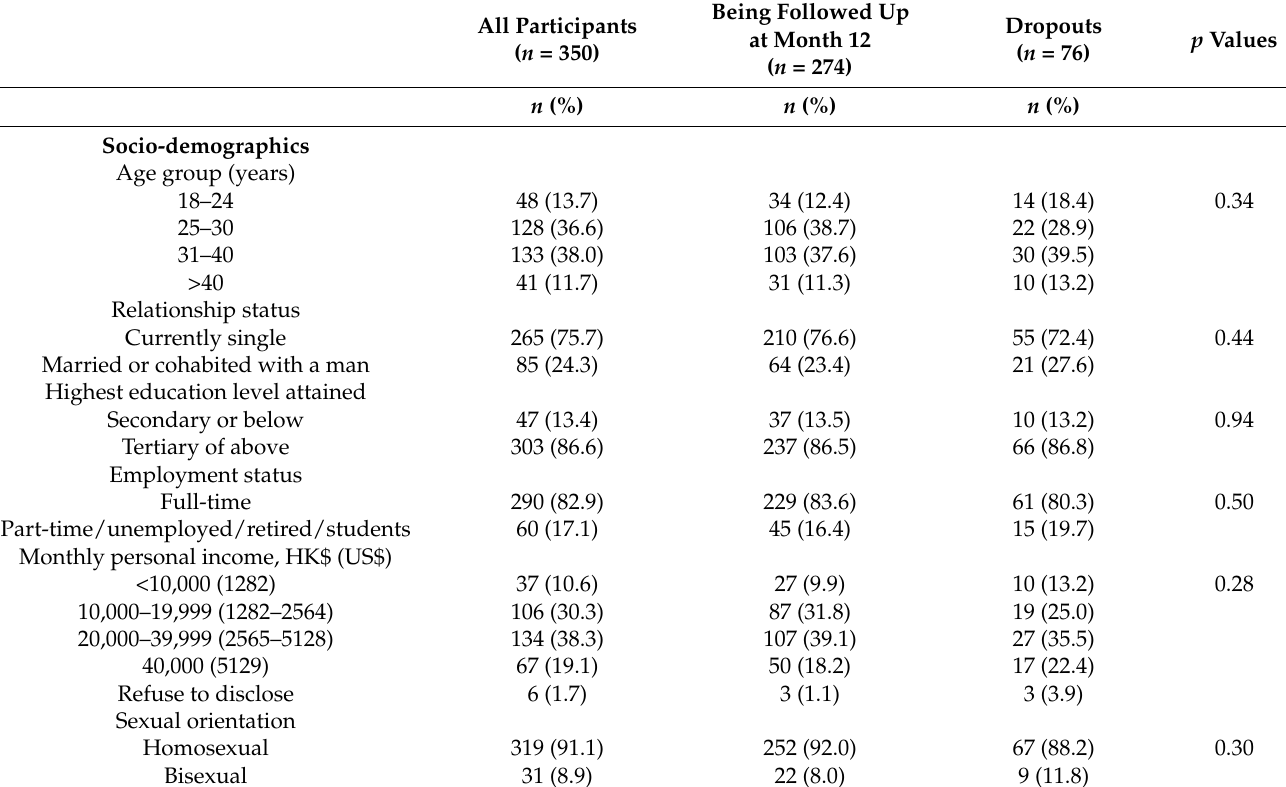
Table 1. Baseline characteristics of the